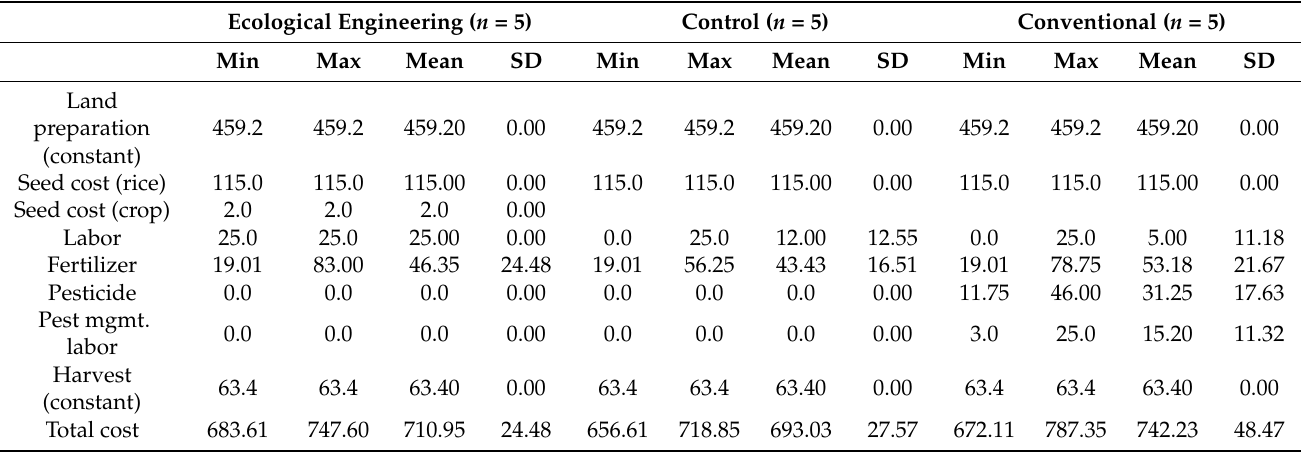
Table 2. Partial benefit–cost analysis (in USD ha − 1 ). To compute the benefit–cost ratio (BCR) only paid-out costs were considered, which excluded the labor costs of the farmer or farm